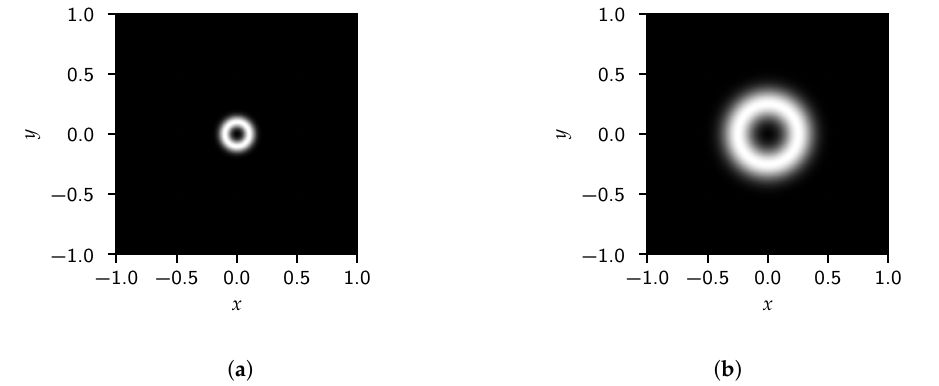
Figure 5. Generated images for a single circle with ( a ) r 0 = 0.1 and ( b ) r 0 = 0.25.